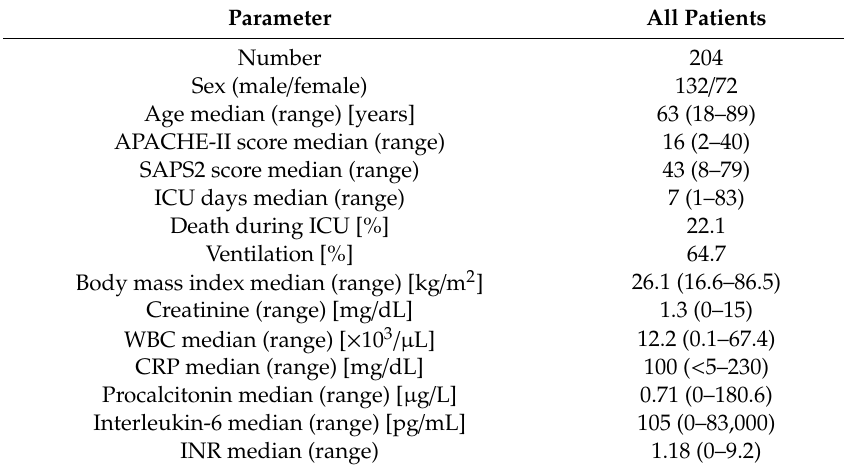
Table 1. Baseline characteristics of the study